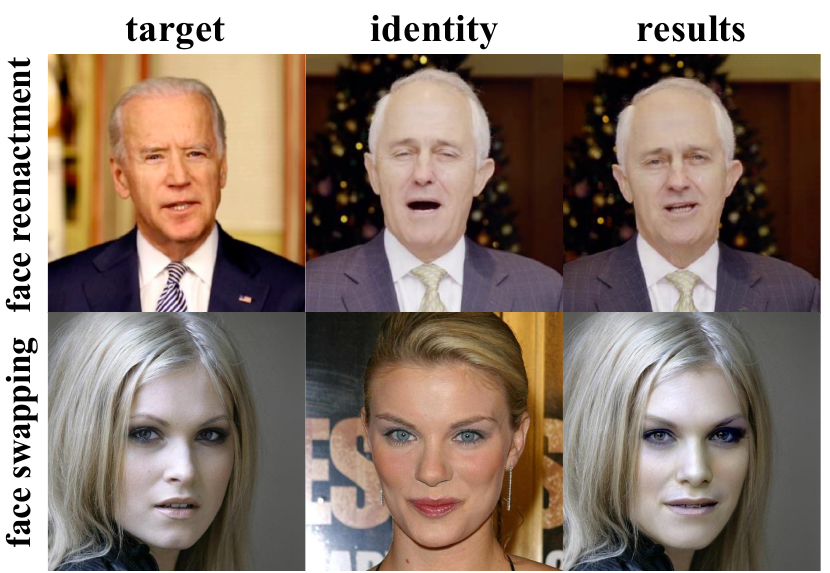
Figure 1. Some technologies realize the results of face forgery. The first line is face reenactment and the second line is face swapping. The result of face swapping is realized by the framework proposed in this